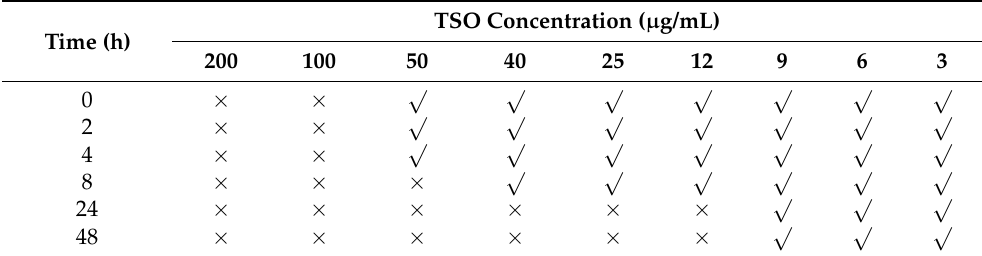
Table 2. Selection of TSO